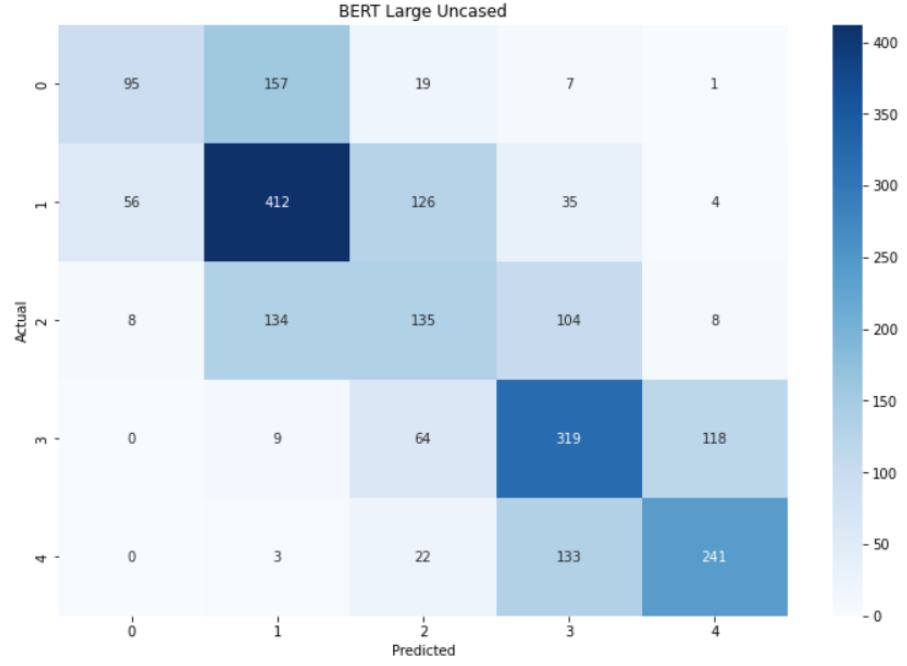
Figure 10. Confusion matrix for BERT LARGE